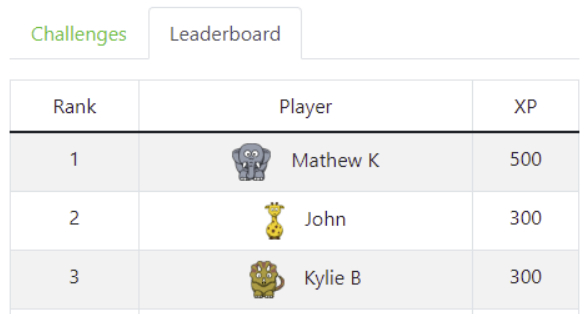
Figure 7. Example of a leaderboard using points and